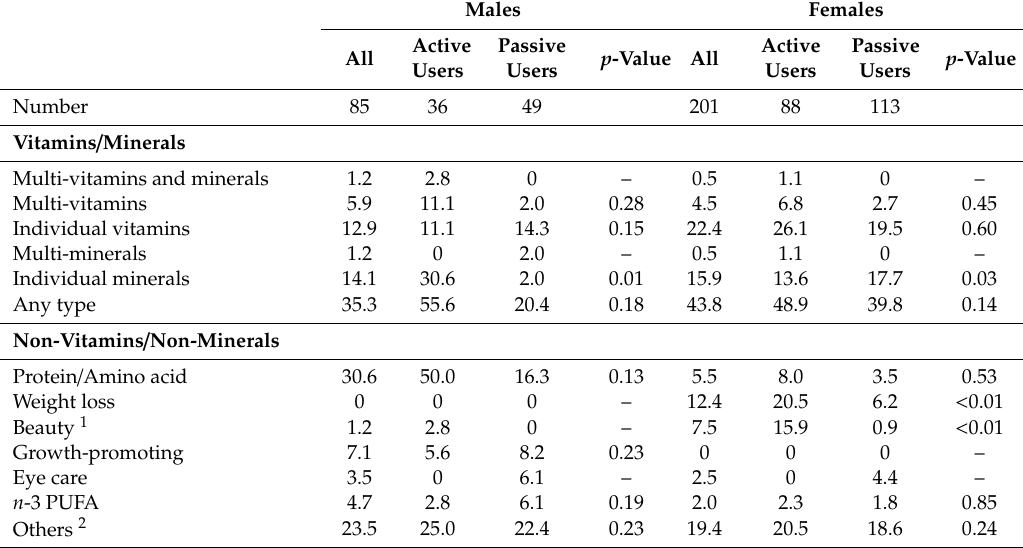
Table 5. A comparison of the types of supplements used by active and passive users (% of